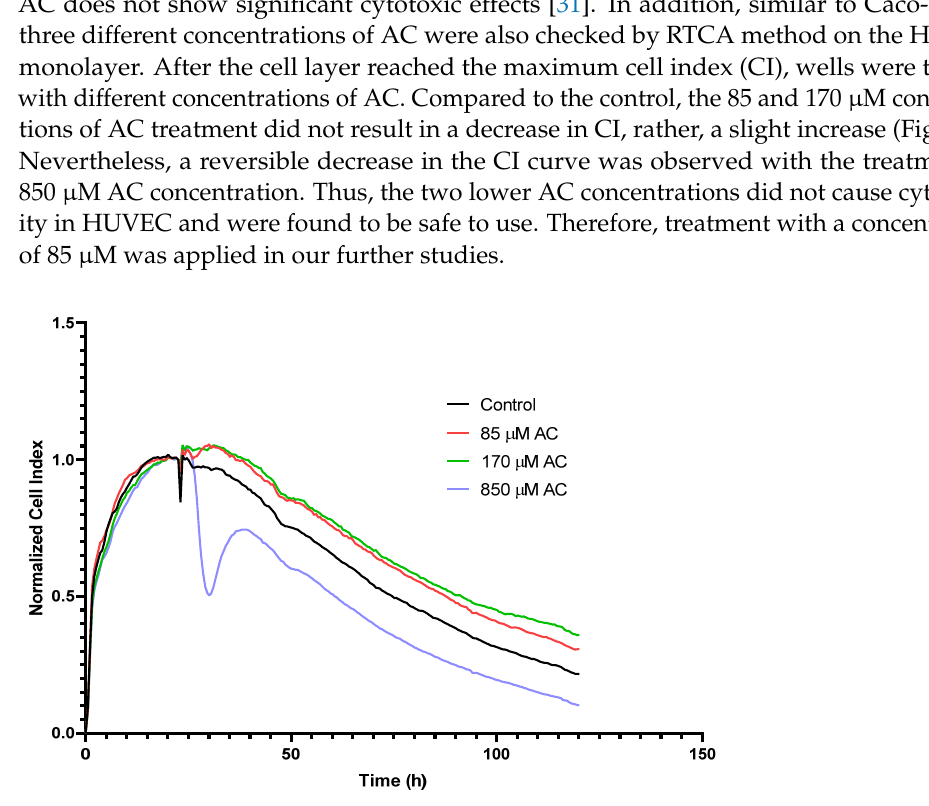
Figure 1. Impedance measurements with real time cell analyzer (RTCA), XCelligence system. Kinetics of epithelial cell response to treatment was monitored using cell index (CI). At the beginning of the plateau phase of growth, cells were treated with AC, at 85; 170; 850 µM concentrations. The Cis were normalized at the time of AC treatment.